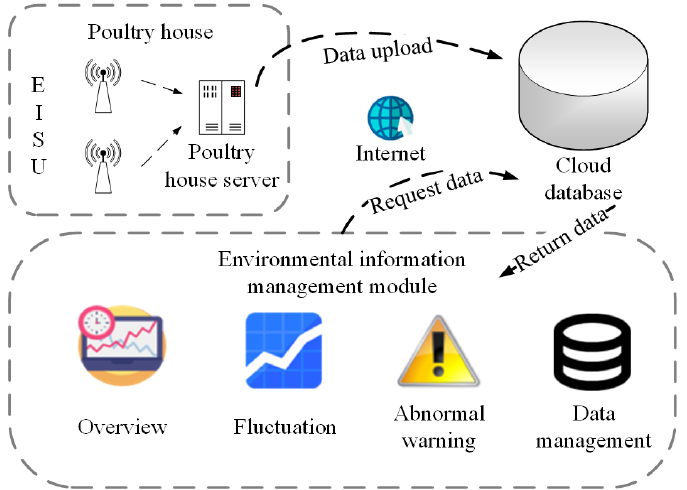
Figure 9. The business process chart of environmental information management module. EISU means environmental information sensing unit.